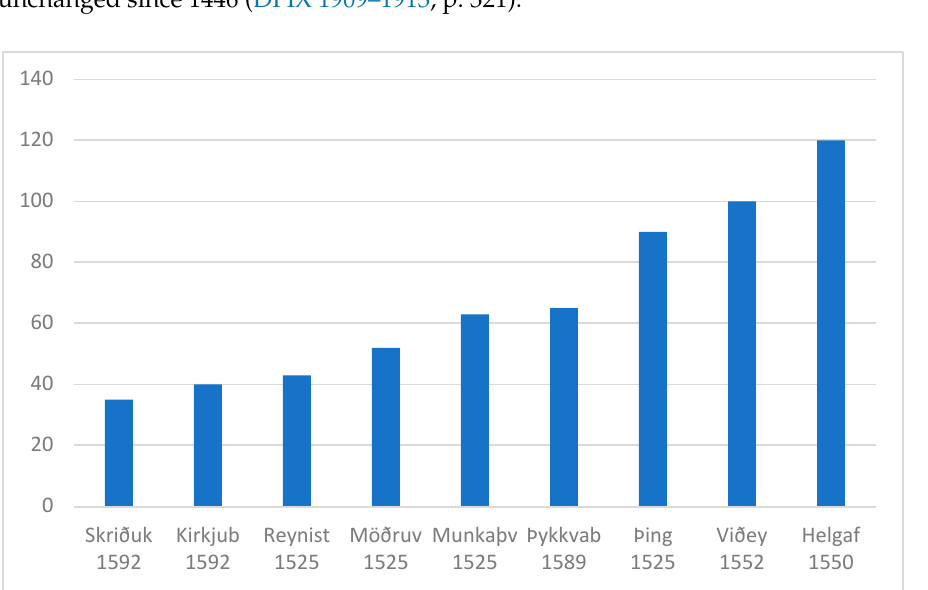
Figure 4. Number of farms owned by the largest monastic houses in Iceland around the time of their dissolution, based on Árni Daníel Júlíusson 2014.